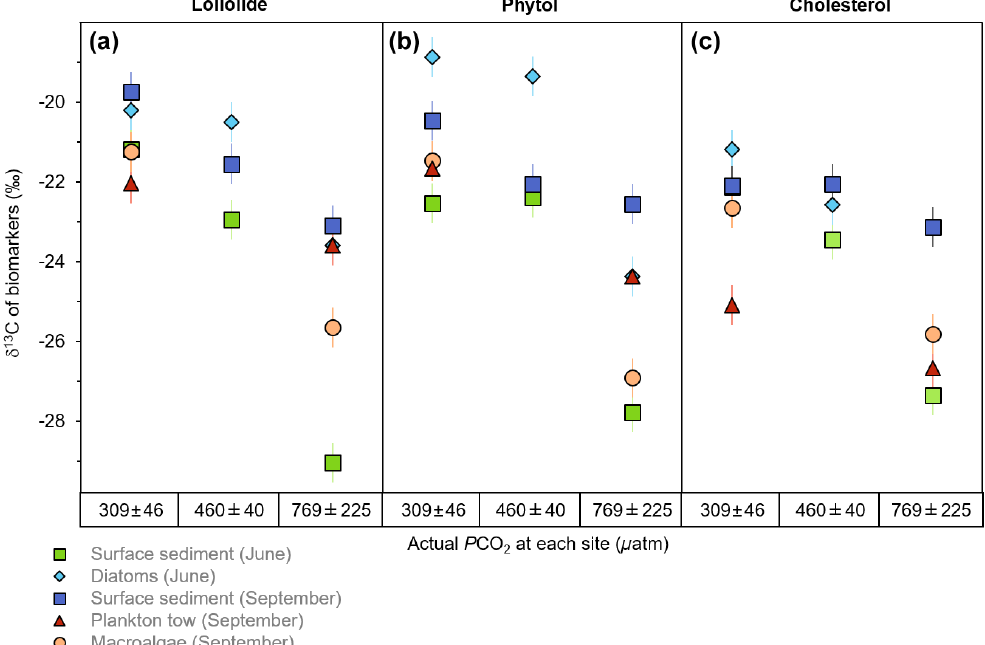
Figure 3. The δ 13 C of general algal biomarkers in sediments. (a) Loliolide, (b) phytol, and (c) cholesterol from the control, mid- p CO 2 , and high- p CO 2 sites during June and September from different sample matrices, including surface sediment (square), benthic diatoms (diamond), plankton tow (triangle), and macroalgae